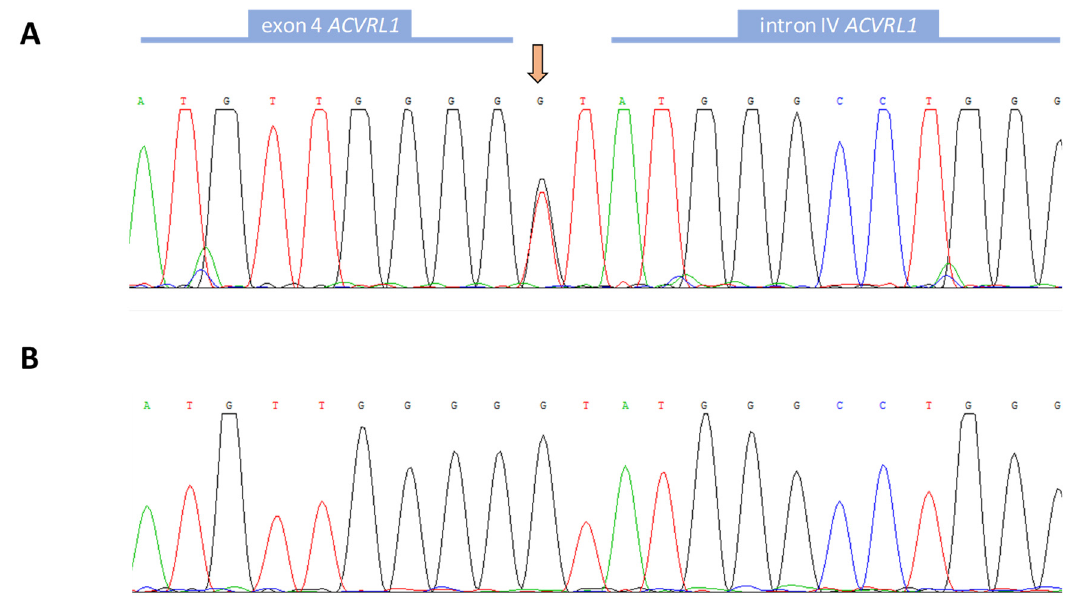
Figure 1. Normal ( B ) and mutated ( A ) exon 4-intron IV boundary sequences of the ACVRL1 / ALK1 gene. These sequences were obtained with a forward primer with the Chromas software.